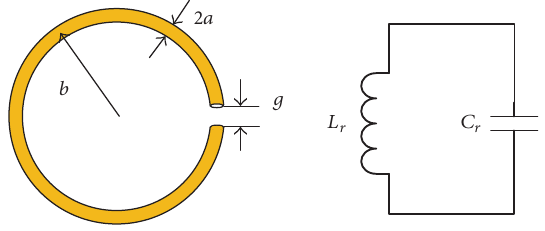
Figure 5: Position variation of the 5.8 GHz split loop ( 𝑥 1 = 10mm, = 20 mm, 𝑧 = 4.2mm, 𝑧 = 10mm, and 𝑧 = 𝑥 2 1 2 3